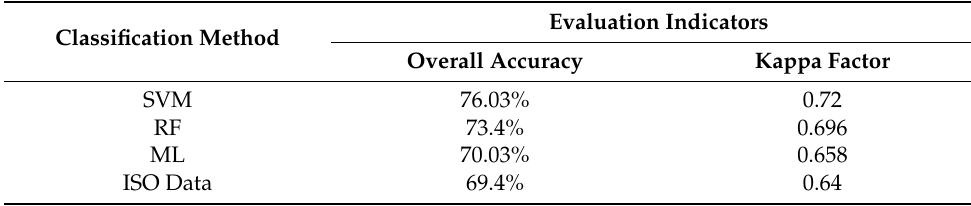
Table 6. Comparison of four types of classification